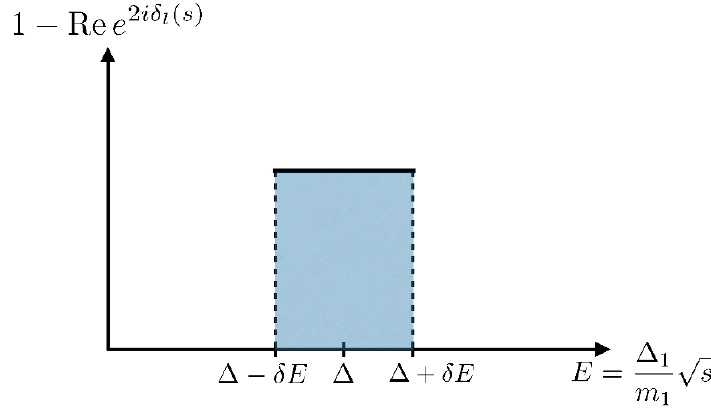
Figure 14 . Each operator of dimension (cid:1) and spin l makes a localized contribution to 1 (cid:0) Re e 2 i(cid:14) l ( s ) . The height of the rectangle is given by (C.68). In the (cid:13)at space limit this contribution becomes proportional to (cid:14) ( s (cid:0) m 2 ). The sum over the contribution of all operators produces a smooth function of s